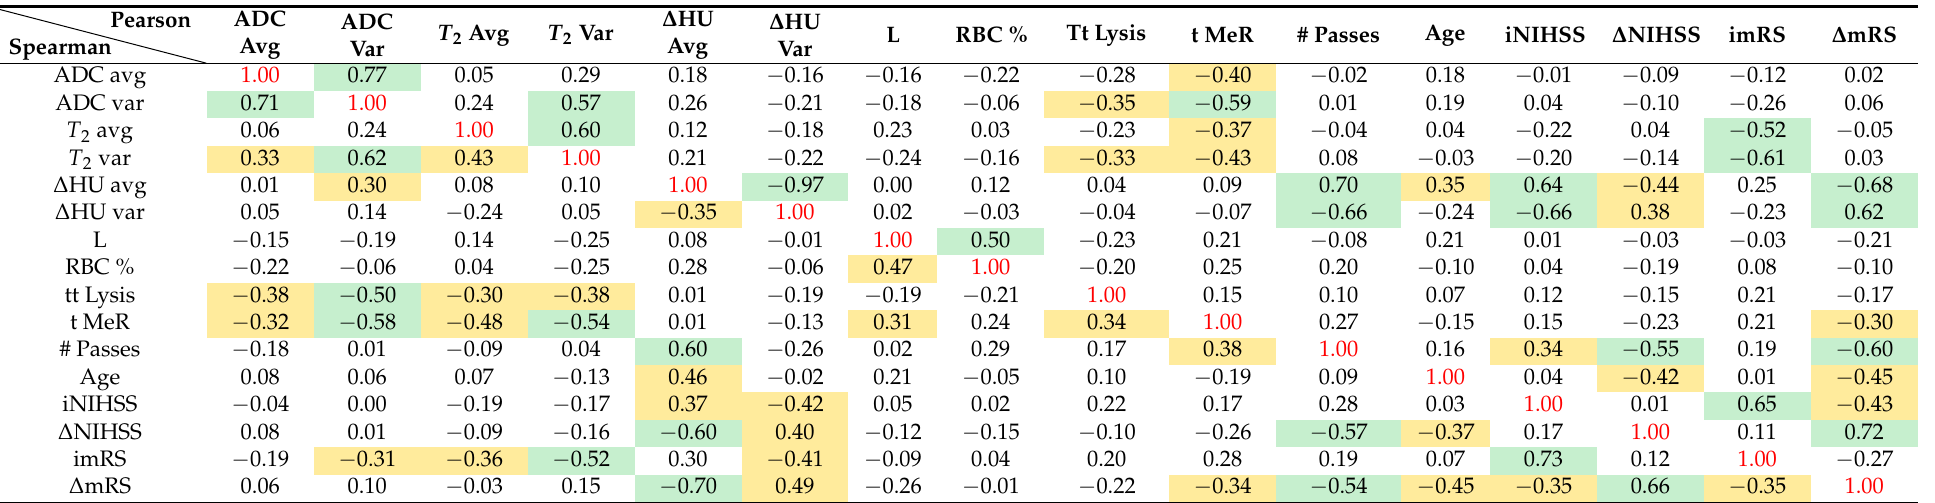
Table 2. Correlation coefficients between different pairs of thrombi parameters. A correlation pair is defined by parameters of row and column of the corresponding cell. Above the table diagonal cells are shown Pearson correlation coefficients, while below them are shown Spearman correlation coefficients. Cells with the absolute value of the correlation coefficient higher than 0.5 are highlighted in green, while those between 0.3 and 0.5 are highlighted in yellow. To better distinguish between Pearson and Spearman correlation coefficients, the diagonal elements are written in